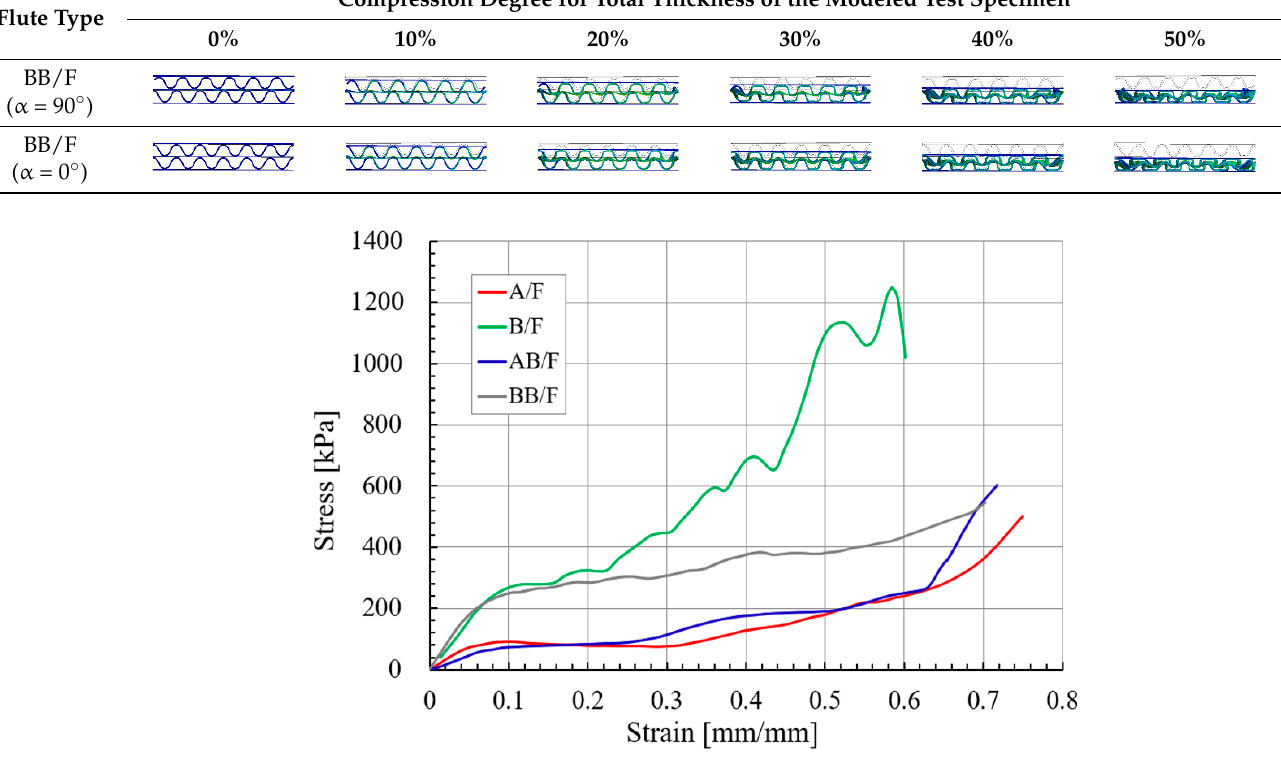
Figure 6. SS curves of the DW corrugated paperboard obtained using FEA.